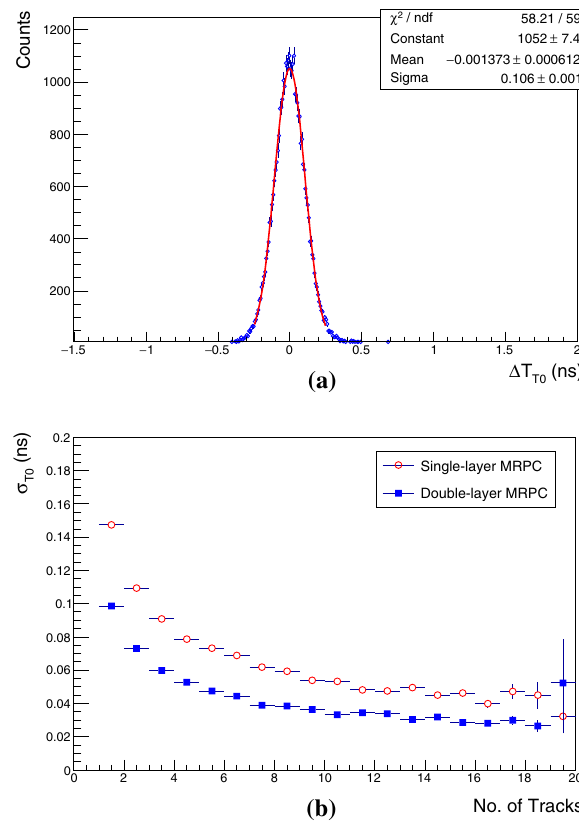
Fig. 25 T0 time resolution from simulation